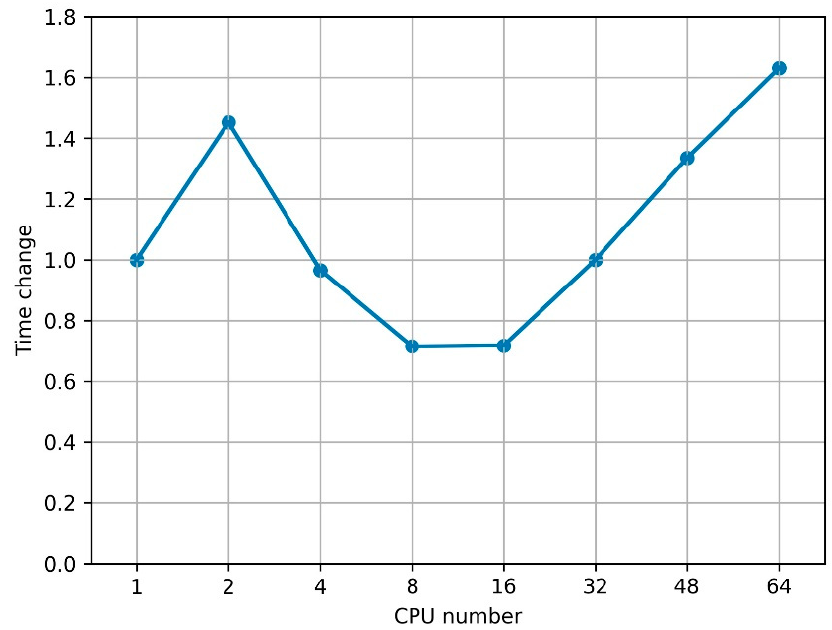
Figure 9. Total running time of the algorithm depending on the number of processes.